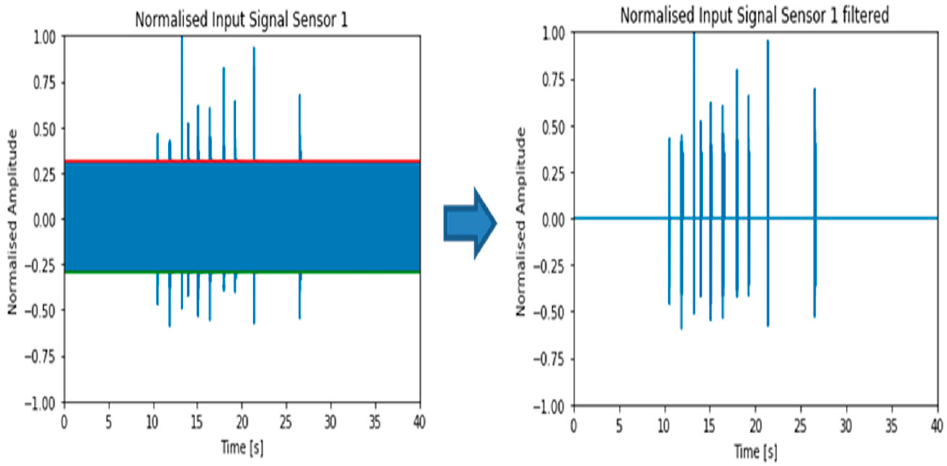
Figure 9. Filtered signals upon consideration of noise buffer.